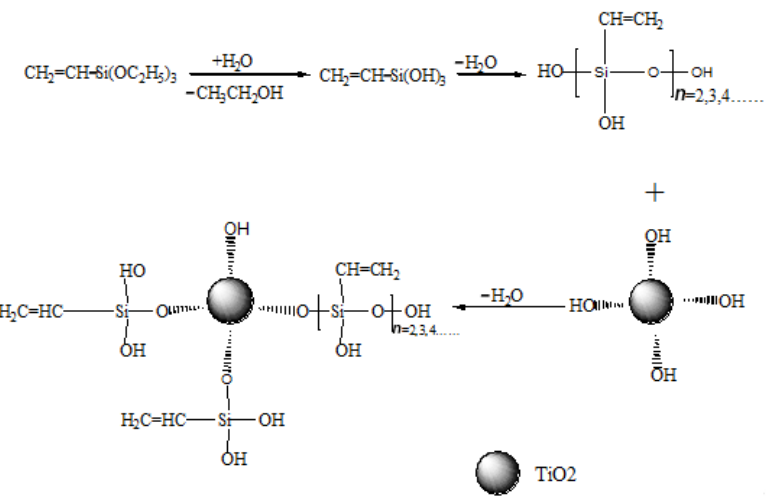
Figure 9. The reaction diagram of TiO 2 nanoparticles with silane coupling agent. The photocatalytic degradation property of the xylan-g-PMMA/TiO 2 fibers was eval-